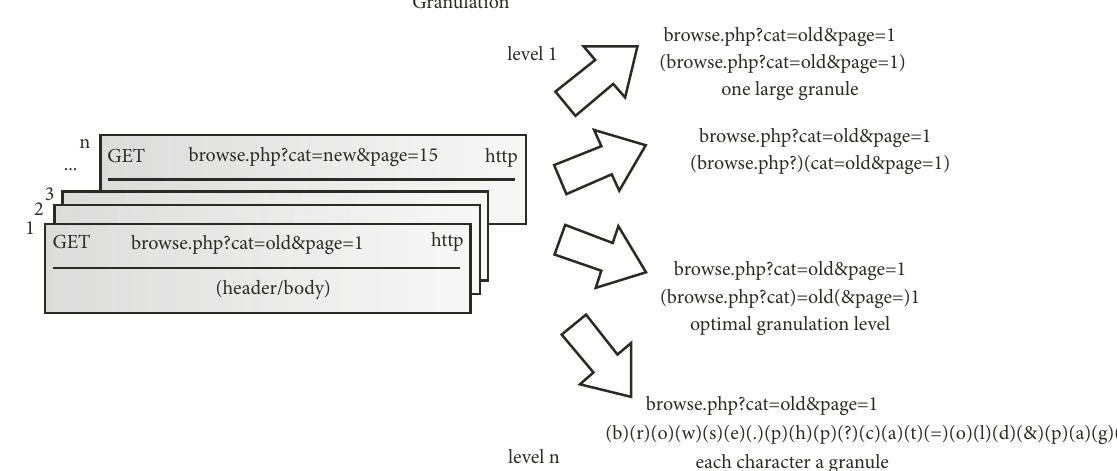
Figure 2: The overview of the granulation algorithm. The HTTP requests undergo a textual semantic segmentation of similar requests. The optimal level of granulation reveals data that can be used to calculate the feature